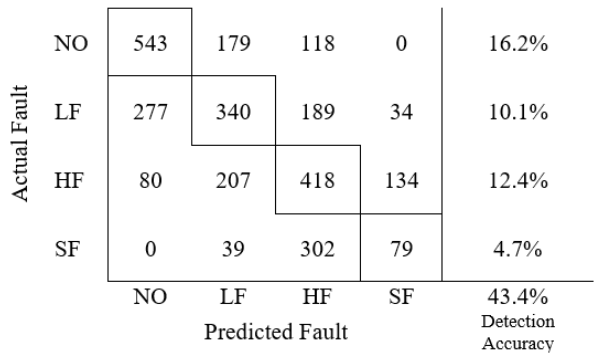
Figure 8. Output confusion matrix for MLP model.